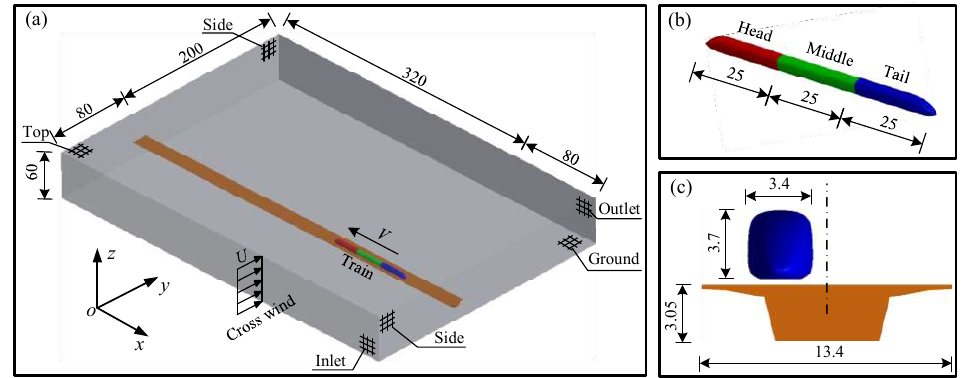
Figure 1. Configuration of numerical model (unit: m): ( a ) flow domain and boundary condition; ( b ) train geometry model; ( c ) train-bridge cross section.